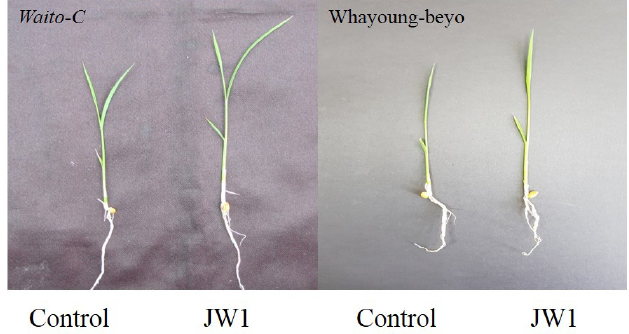
Fig. 4: Influence of B. subtilis JW1 culture filtrates (10 μl) on growth at- tributes of Waito-C and Whayoung-beyoseedlings after seven days of